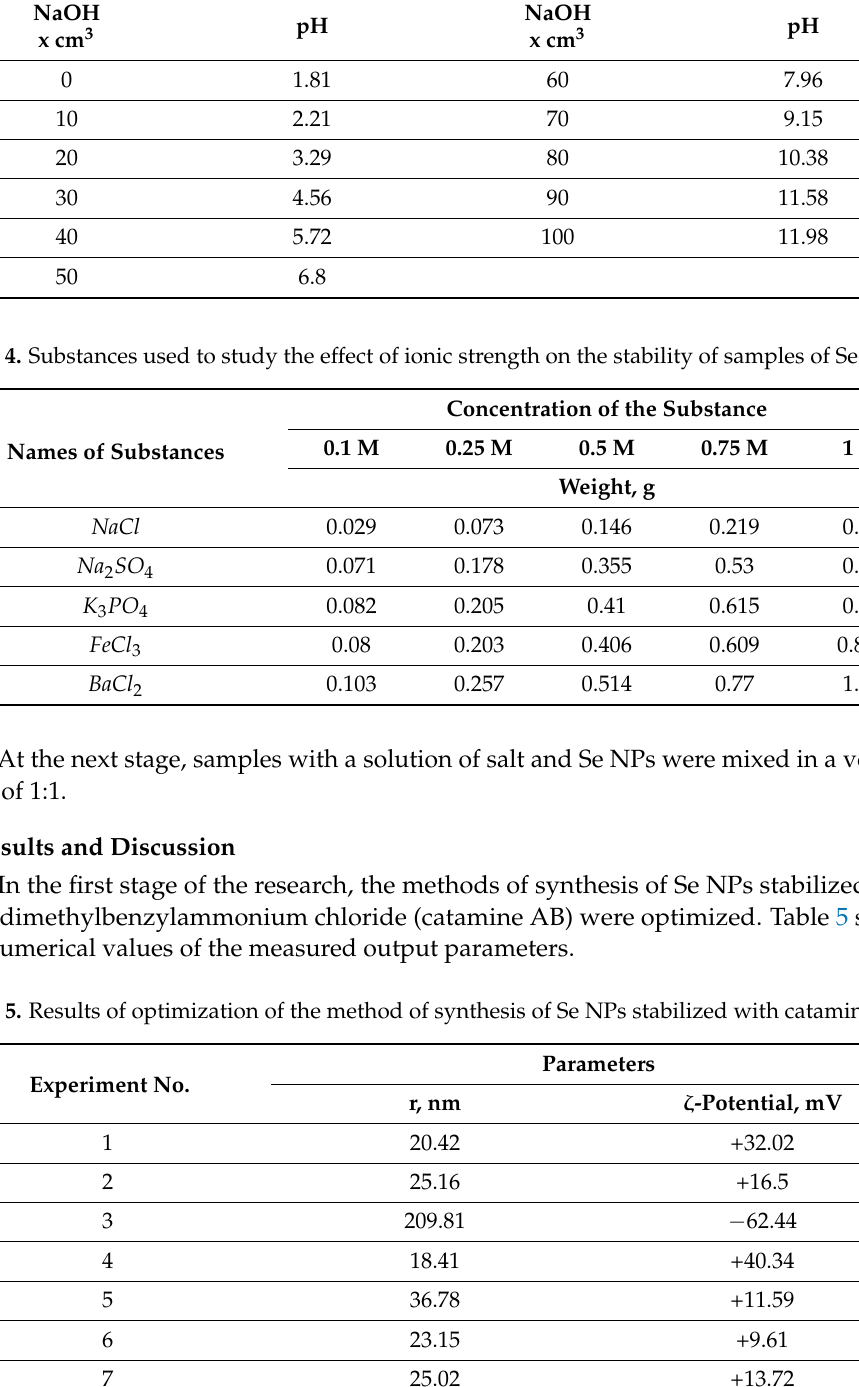
Table 3. NaOH volume values with corresponding pH values.